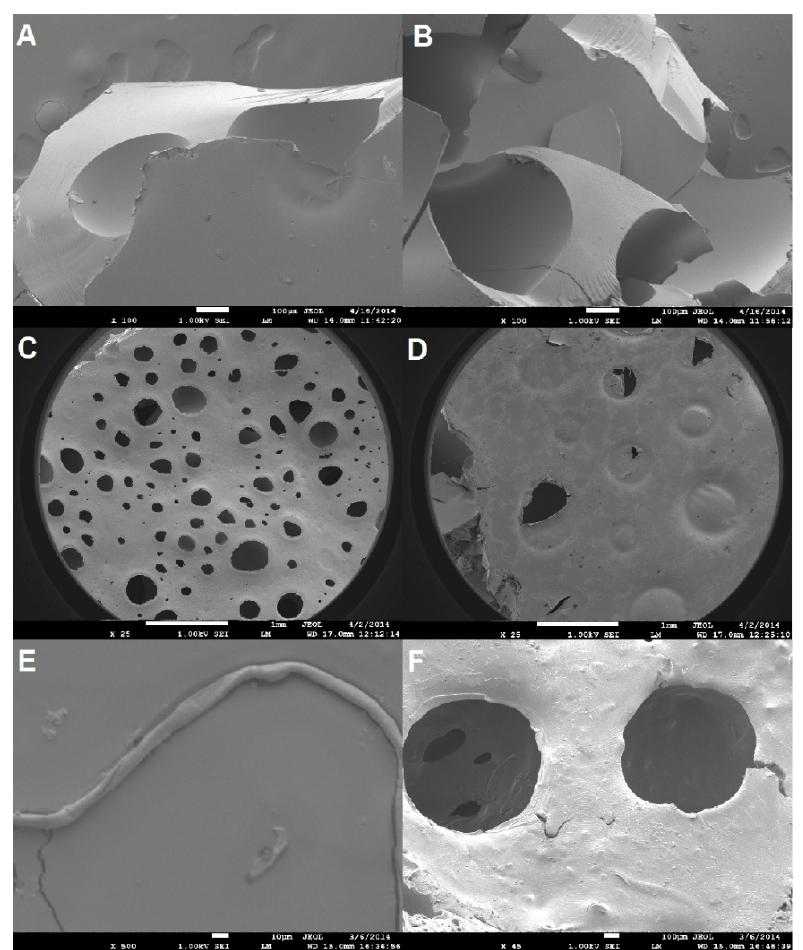
Figure 8. SEM images of ( A ) cryo-fracture surface of PUBIMO-15.1 at 100× (the scale bar corresponds to 100 µm); ( B ) cryo-fracture surface of PUBIMO-13.6 at 100× (the scale bar corresponds to 100 µm); ( C ) PUMO-11.3 at 25× (the scale bar corresponds to 1 mm); ( D ) PUBIMO-15.1 at 25× (the scale bar corresponds to 1 mm); ( E ) PUBIMO-11.3-20 at 500× (the scale bar corresponds to 10 µm); and ( F ) PUBIMO-11.3-20 at 45× (the scale bar corresponds to 100